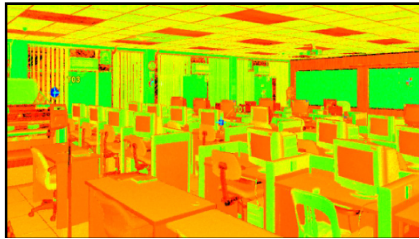
Figure 6. Point clouds produced by laser scanner